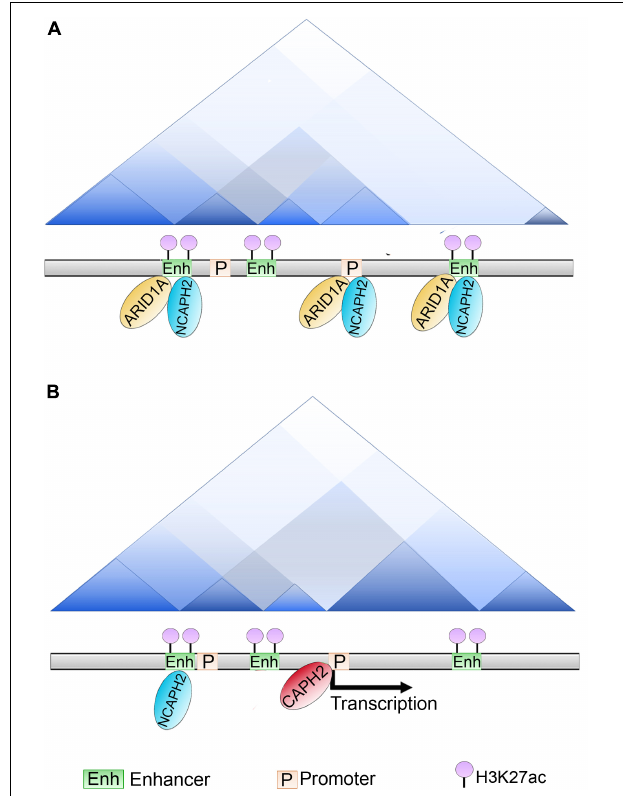
FIGURE 6 | Role of ARID1A in compartments and TADs establishment. (A) In ovarian cancer cell lines ARID1A is present at enhancers and promoters co-localizing with the condensin subunit NCAPH2 (that recognizes and binds to H3K27ac marked enhancers). (B) Upon ARID1A depletion, NCAPH2 relocalizes to a subset of promoters. CAPH2 re-localization induces the gene expression of these promoter targets, whether this activity is responsible for B to A compartment switching is still